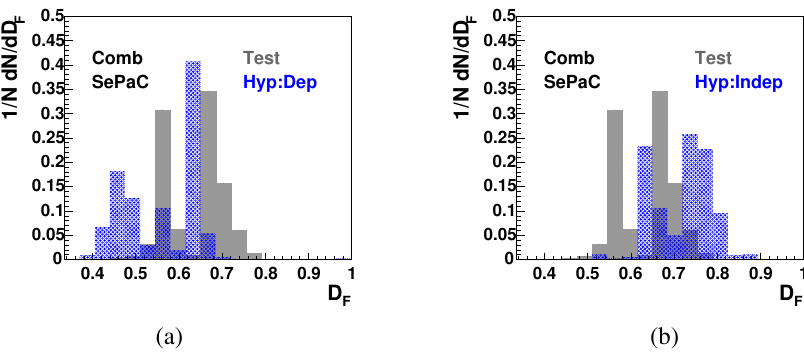
Figure 3. The event distributions by dimension D F for combined (gray area) and reconstructed (blue area) fractals. The hypotheses of dependent (a) and independent (b) partition of the SePaC method are